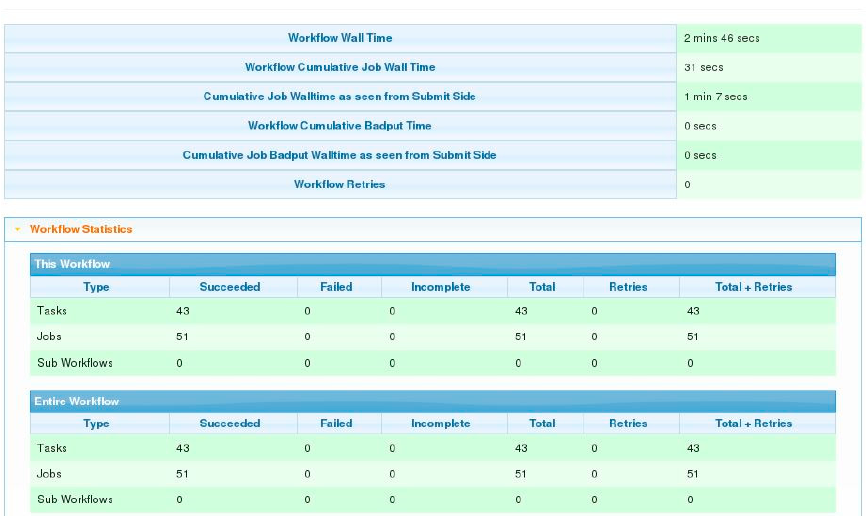
Figure 11. The number of jobs and tasks and their status.